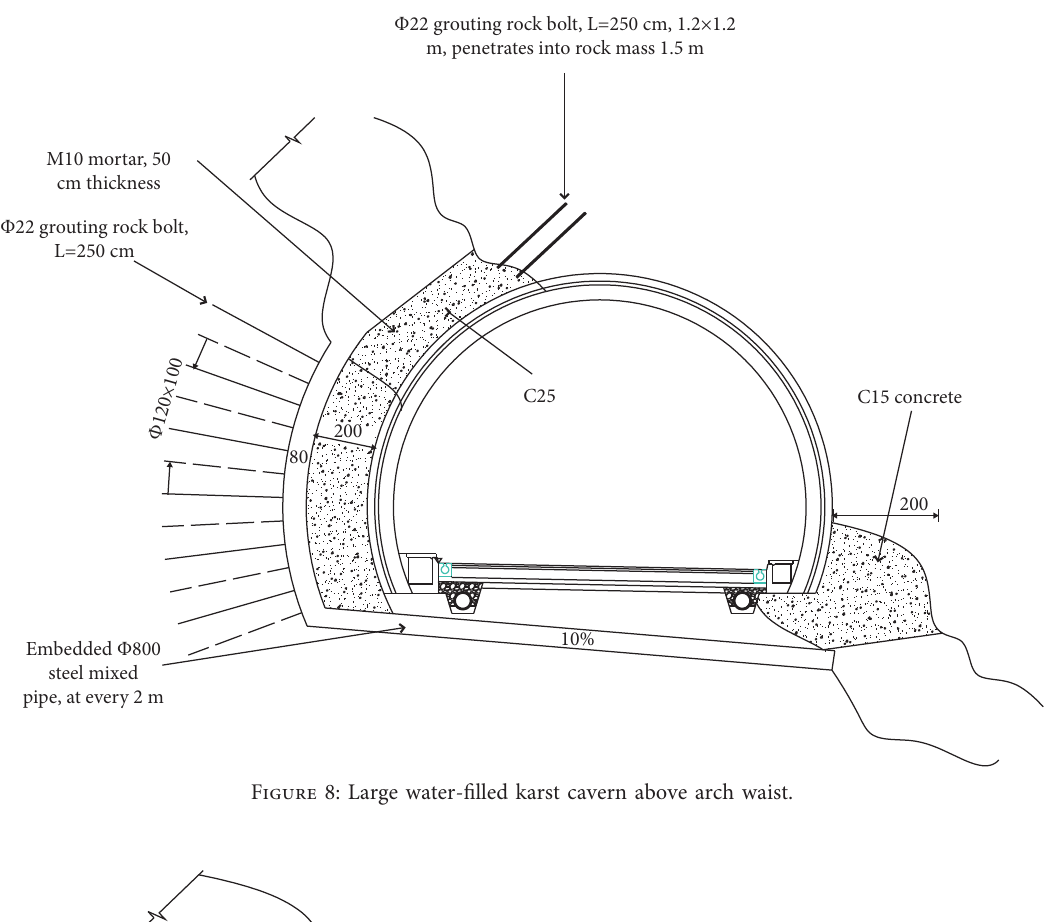
Figure 8: Large water-filled karst cavern above arch waist.